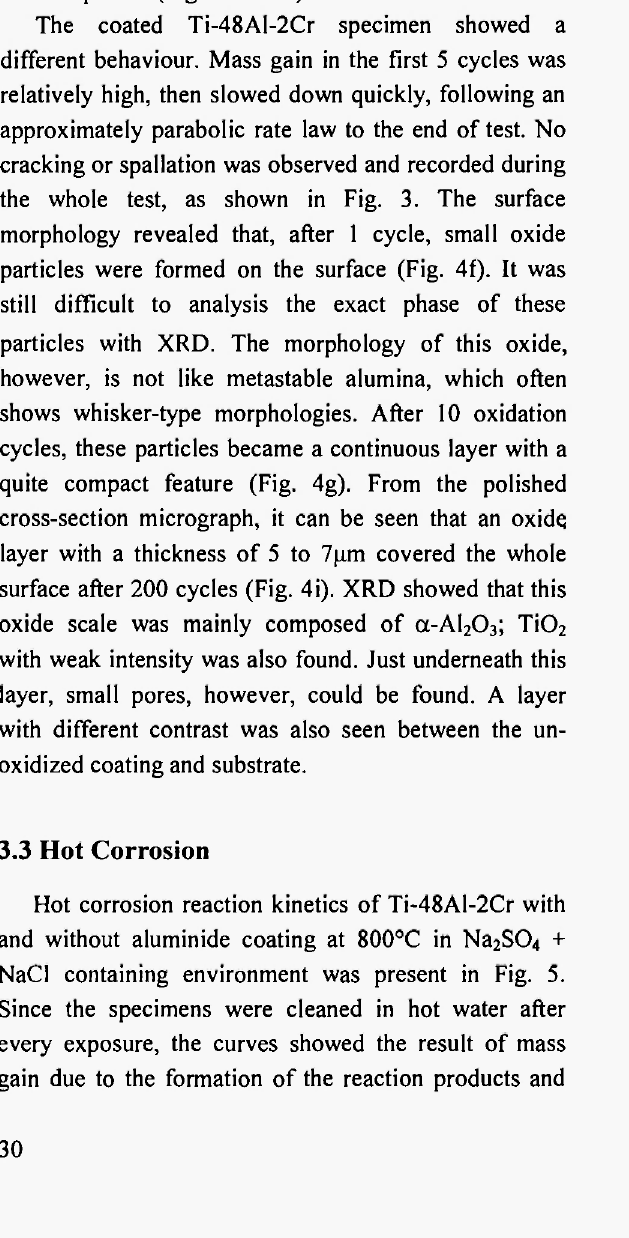
Fig. 5: Hot corrosion kinetics of Ti-48Al-2Cr with and without aluminide coating at 800°C. Corrosive agents: 90wt.%Na 2 S0 4 +